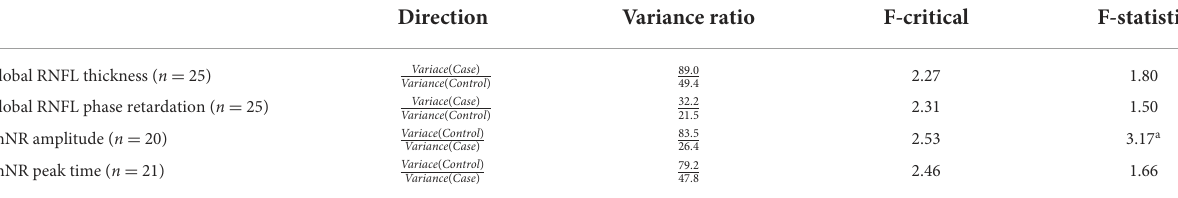
TABLE 3 Inter-cohort comparison of the variance of the primary imaging and electroretinography outcome measures.